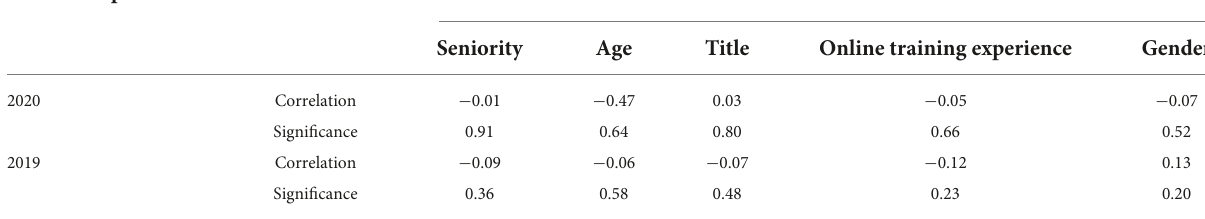
TABLE 6 Correlation between the total platform score and variables. Version of